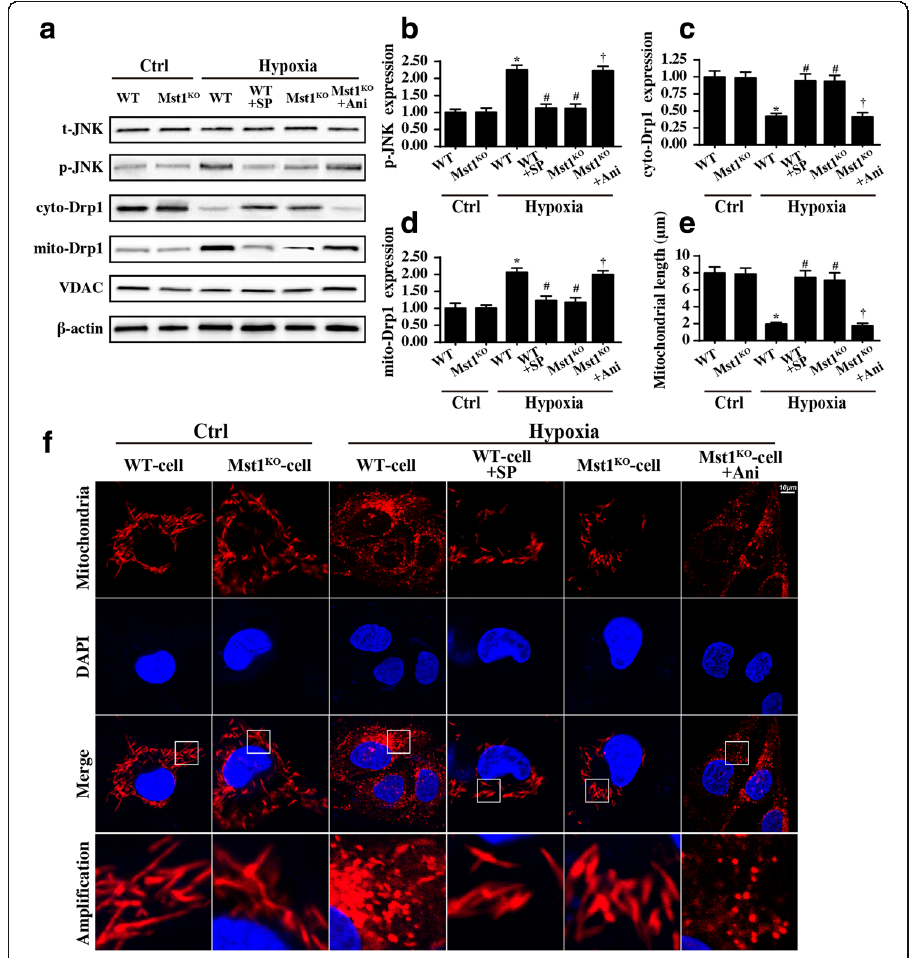
Fig. 6 Mst1 regulated mitochondrial fission via the JNK-Drp1 pathway. a – d Western blotting was performed to analyze the signaling pathways. SP600125 (SP) was used to inhibit JNK activation (WT + SP). Anisomycin (Ani), an activator of JNK, was applied in Mst1-knockout cells to reactivate the JNK (Mst1 KO + Ani). e and f Mitochondrial fission and mitochondrial length were measured with JNK activation and inhibition. * p < 0.05 vs. ctrl group, # p < 0.05 vs. WT-cell+hypoxia, † p < 0.05 vs. Mst1 KO